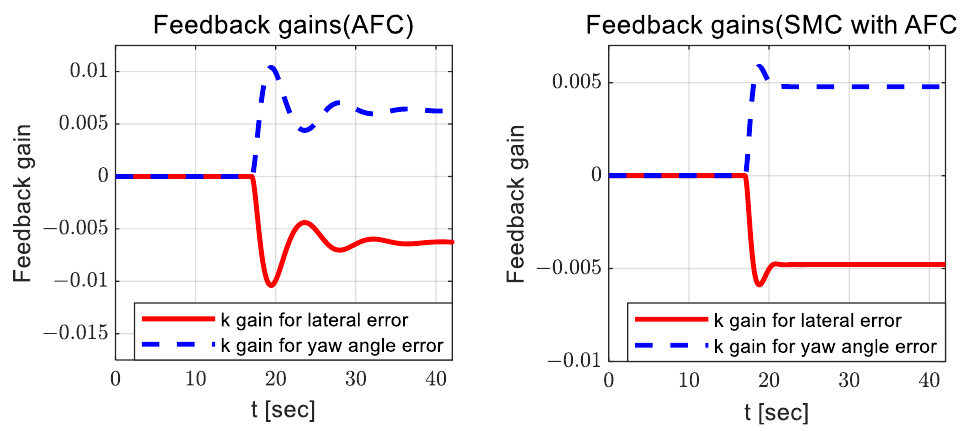
Figure 17. Results: adapted feedback gains (AFC — left ; SMC with AFC — right ) for the lane change.